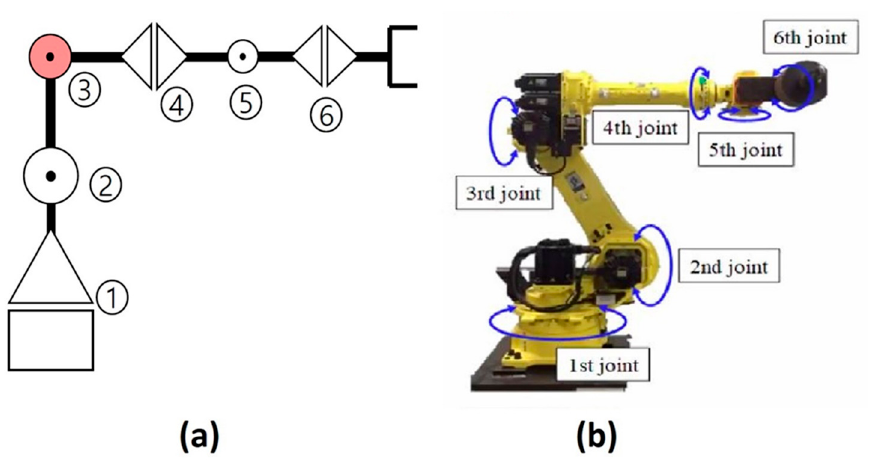
Figure 3. ( a ) Free body diagram, and ( b ) Hyundai robot YS080.